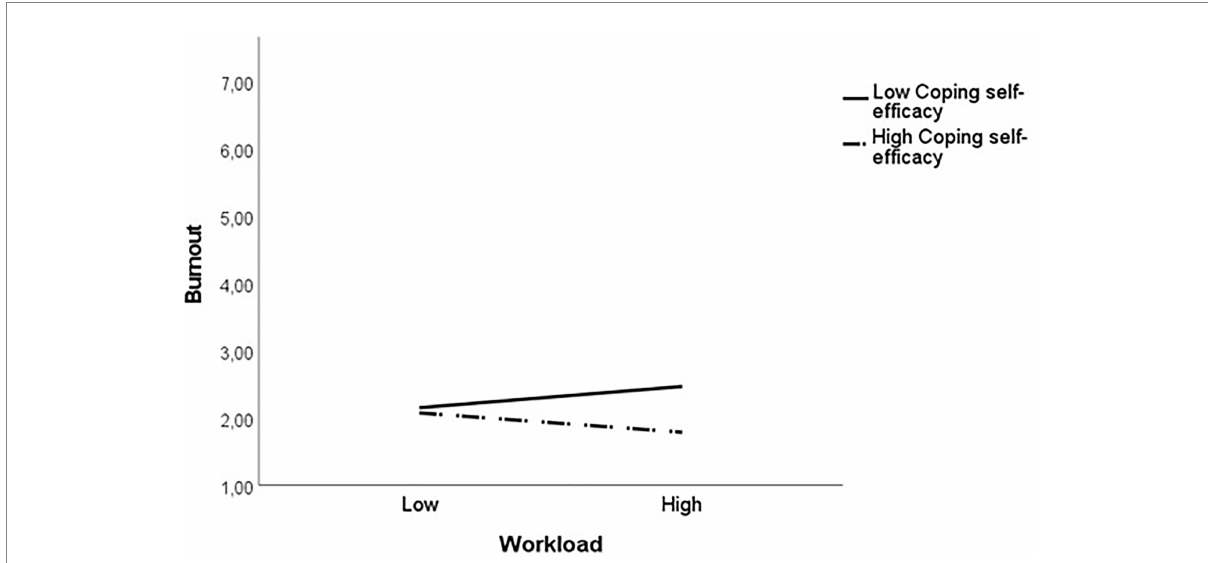
FIGURE 4 Moderating effect of coping self-efficacy T1 on the relationship between workload T1 and burnout T2. All predictor variables in this figure are centred and standardised. Predictor levels: Low = 1 SD below the mean, High = 1 SD above the